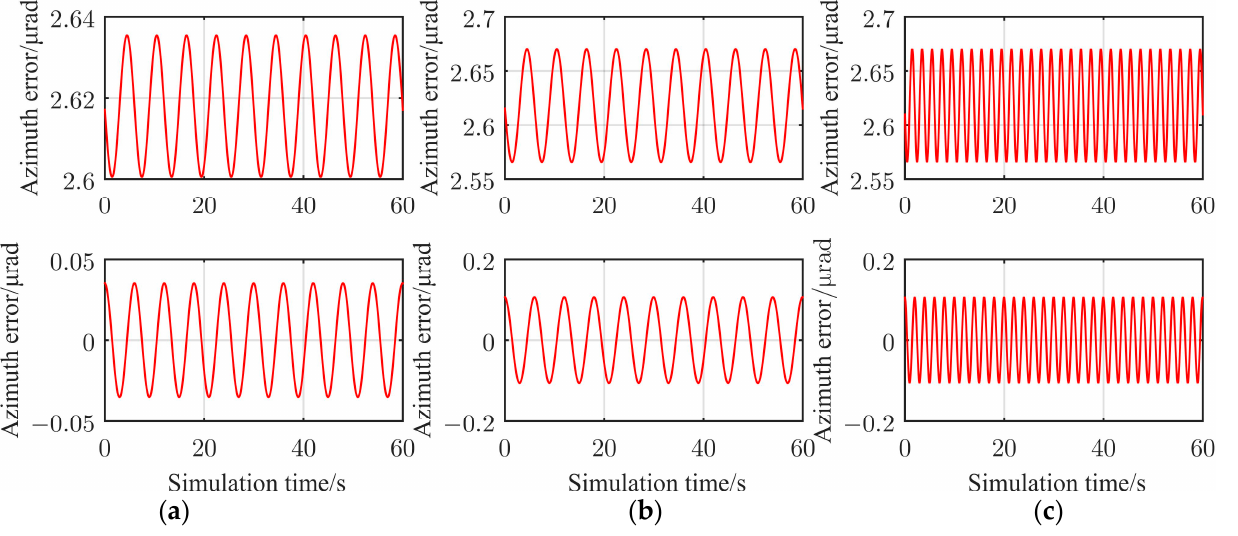
Figure 9. The LOS a tt itude curves under the condition of conical motion in an ideal state in the